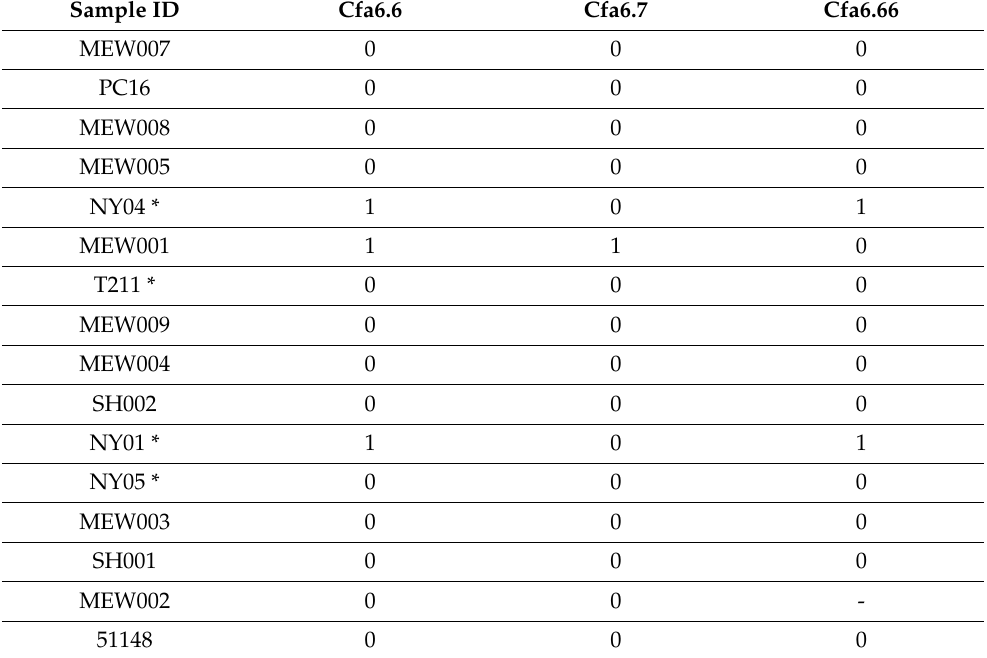
Table 3. Number of transposable element insertions associated with canine human-directed hyperso- ciability per locus. Missing data are indicated by “-”. The asterisk indicates coyotes that had been documented interacting with